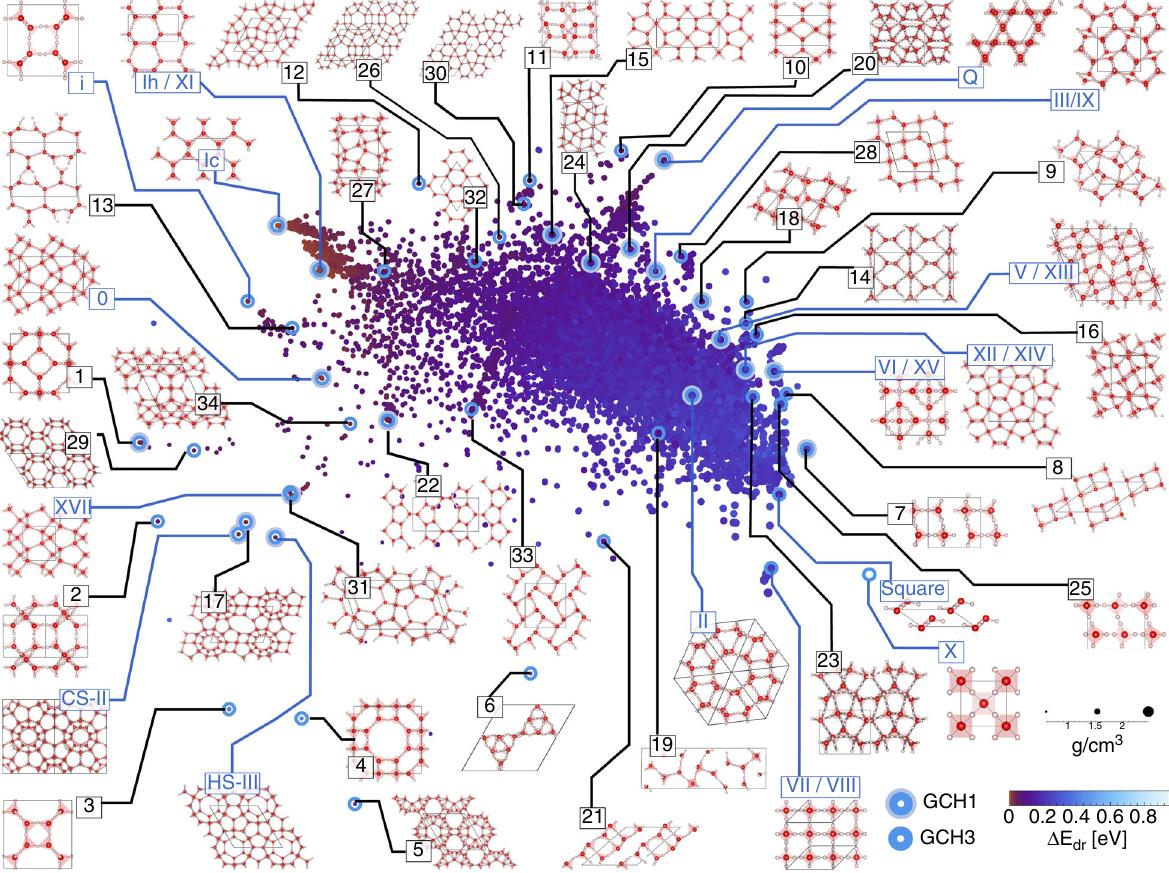
Fig. 3 Sketch map of the structural similarity of 15,869 distinct PBE-DFT geometry-optimised ice structures. The sketch-map coordinates correlate strongly with density and con fi gurational energy but ultimately measure abstract structural features, which leaves their numerical value without intuitive meaning. They are therefore not shown. Instead the density and static lattice energy of each structure is encoded by the size and colour of the respective point on the map. Known ice phases are labelled in blue. The 34 new candidates are labelled in black and numbered in order of increasing dressed energy relative to the GCH3. Their atomic structures are shown to highlight their structural